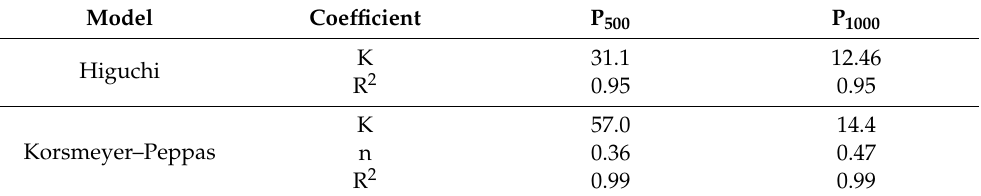
Table 7. Coefficients obtained from the controlled release according to the Higuchi and Korsmeyer– Peppas mathematical